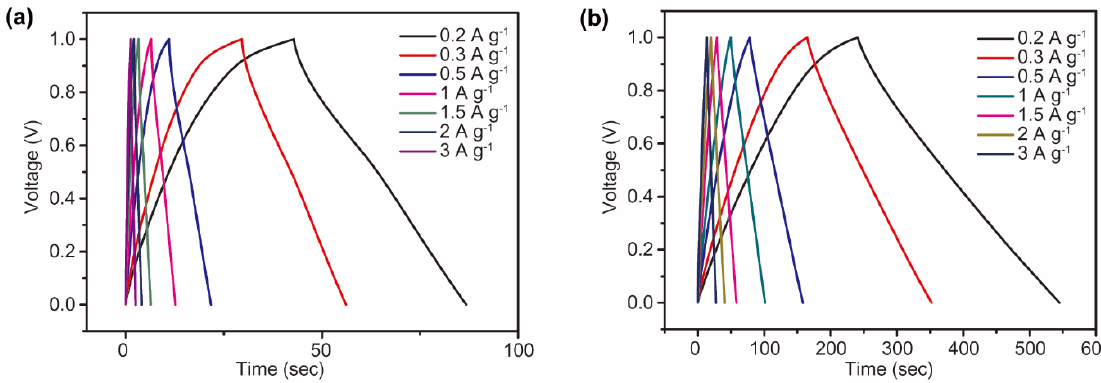
Figure 6. The charge/discharge profiles of ( a ) SWNT electrodes and ( b ) c-SWNT electrodes at current densities from 0.5 to 3 A g − 1 .